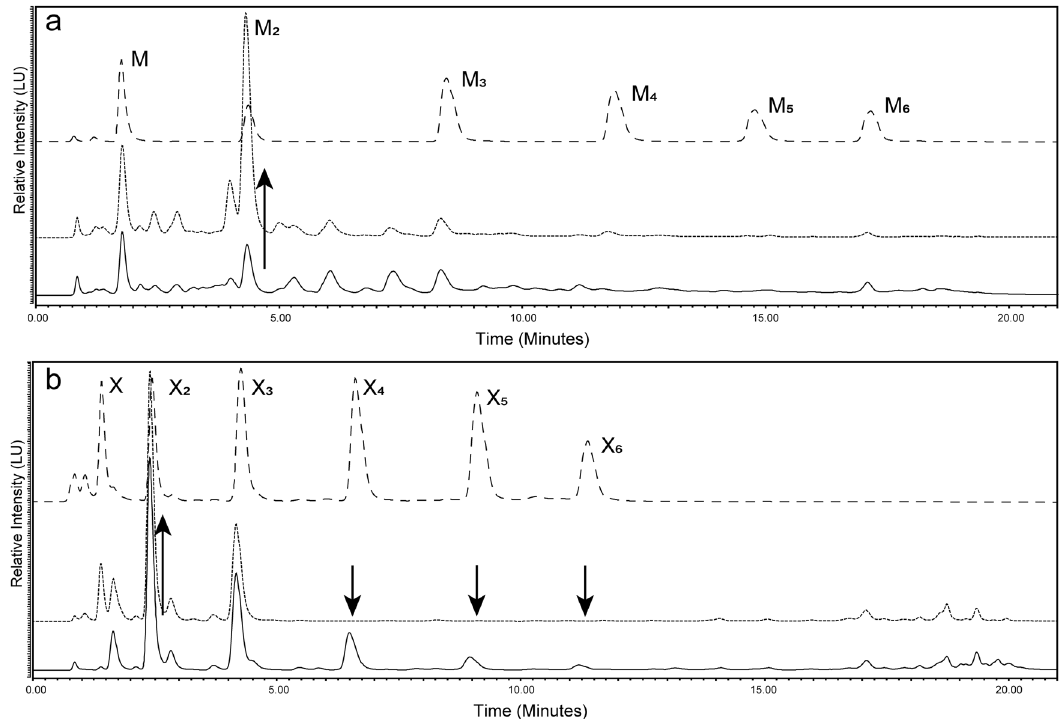
Fig. 5 Monitoring of fl uorescently labelled substrate metabolism by HPLC-HILIC-FLD. a B. cellulosilyticus grown on GH26-AcGGM — Mannose 1 – 6 standards (dashed line), 2-AB-labelled GH26-AcGGM (dotted line) and 24 h supernatant sample (solid line). A clear increase (upwards arrow) in mannobiose is observed whilst an overall reduction in complexity is also noticeable. M mannose, M 2 mannobiose, M 3 mannotriose, M 4 mannotetraose, M 5 mannopentaose, M 6 mannohexaose. b B. cellulosilyticus grown on 2-AB-labelled GH10-AGX — Xylose 1 – 6 standards (dashed line), 2-AB-labelled GH10-AGX (dotted line) and 24 h supernatant sample (solid line). A clear reduction in levels of xylotetraose, xylopentaose, and xylohexaose (downwards arrows) was observed whilst an accumulation of xylobiose (upwards arrow) was highly pronounced. X xylose, X 2 xylobiose, X 3 xylotriose, X 4 xylotetraose, X 5 xylopentaose, X 6